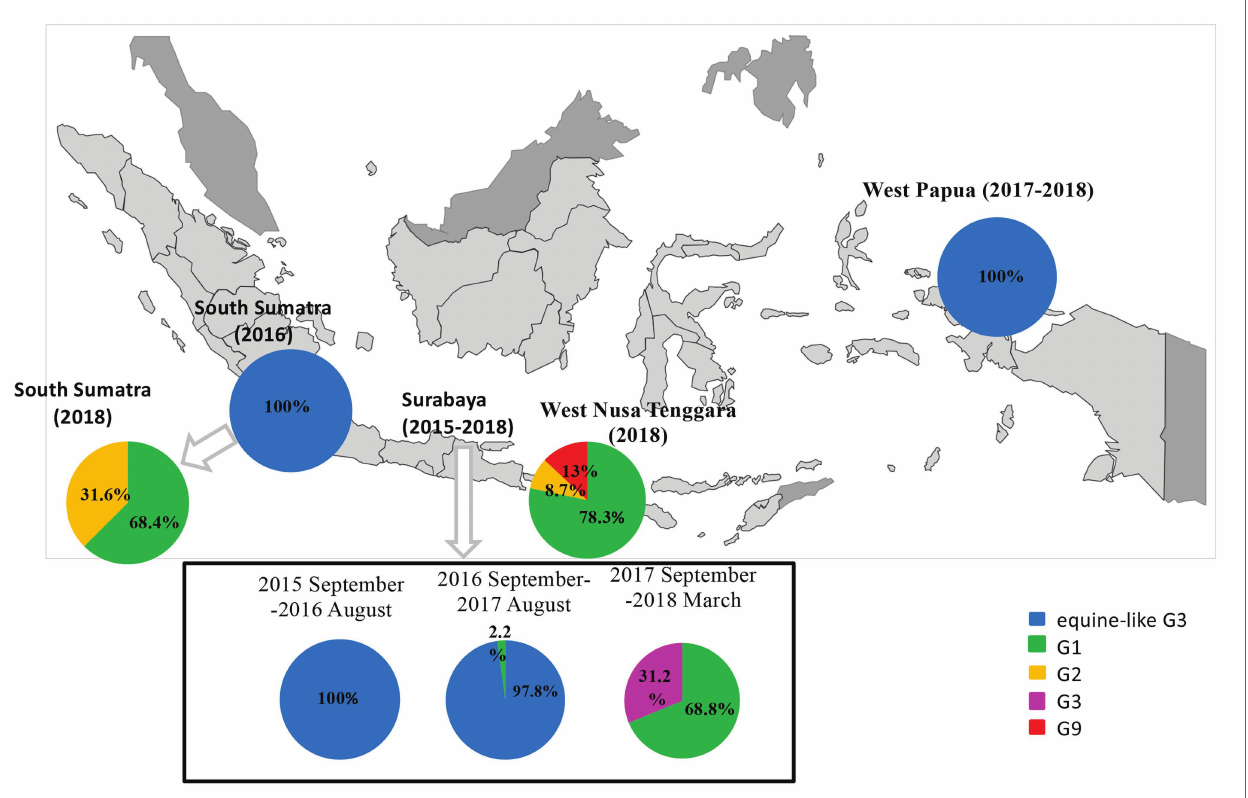
FIGURE 1 | Distribution and change of G-genotypes among children with RVA infections in three islands in Indonesia (West Nusa Tenggara, South Sumatra, and West Papua) in 2016–2018 and East Java as a reference in